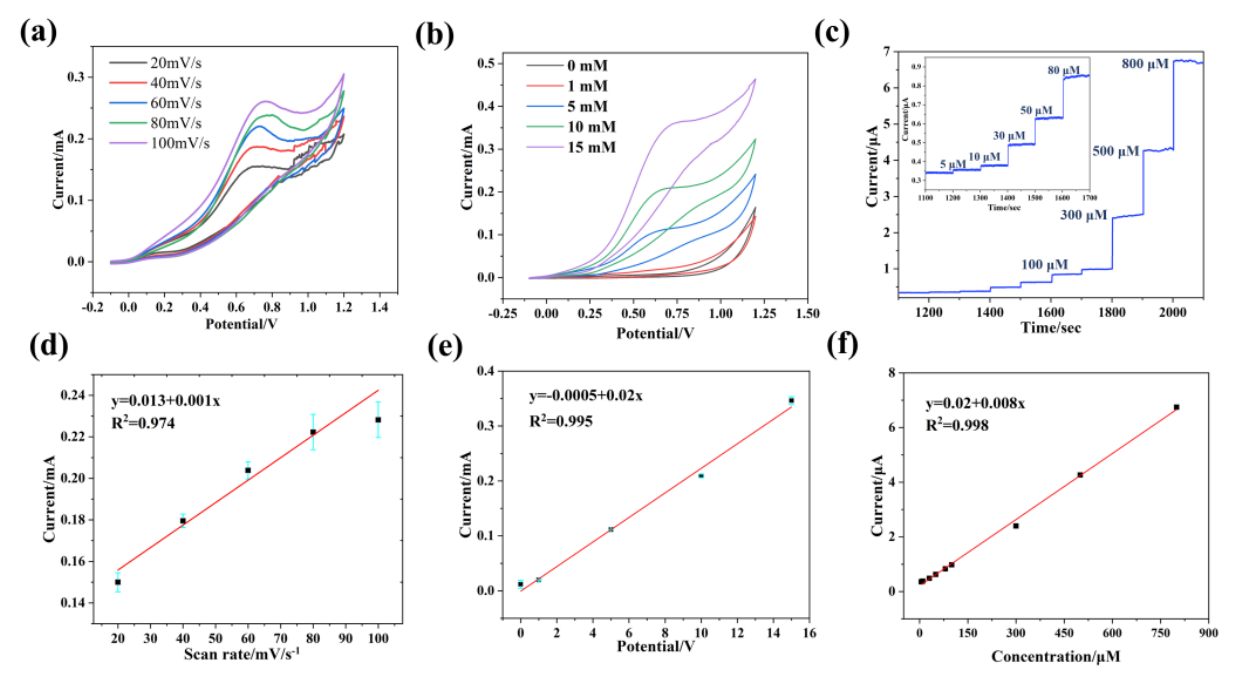
Figure 5. Electrochemical tests of CuS-PNSs/Ti 3 C 2 /GCE in H 2 O 2 detection: ( a ) current response of CuS-PNSs/Ti 3 C 2 /GCE toward H 2 O 2 with different scan rates of 20 – 100 mV s − 1 ; ( b ) current response of CuS-PNSs/Ti 3 C 2 /GCE toward H 2 O 2 with different concentrations of 0 – 15 mM; ( c ) I – T response of different concentrations of H 2 O 2 ; ( d ) linear calibration of CV response with different scan rates of 20 – 100 mV s − 1 ; ( e ) linear calibration of CV response with H 2 O 2 concentration from 0 to 15 mM; ( f ) linear calibration of I – T response with H 2 O 2 concentration from 5 – 800 µM.